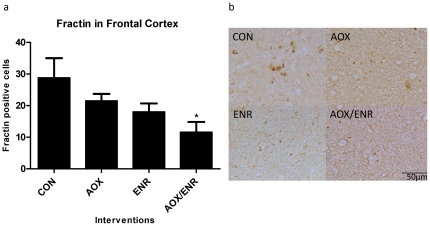
Activation of caspase 3 is associated with increased levels of caspase-3 cleavage products.
a) Fractin immunohistochemical staining in frontal cortices of aged dogs treated with AOX and/or ENR interventions showed significant reduction in expression of active caspase 3 in the E/A group *p<0.05. CON: control environment/control diet; AOX: control environment/antioxidant diet; ENR: behavioral enrichment/control diet; AOX/ENR: behavioral enrichment/antioxidant diet b) representative images of fractin staining in frontal cortices.